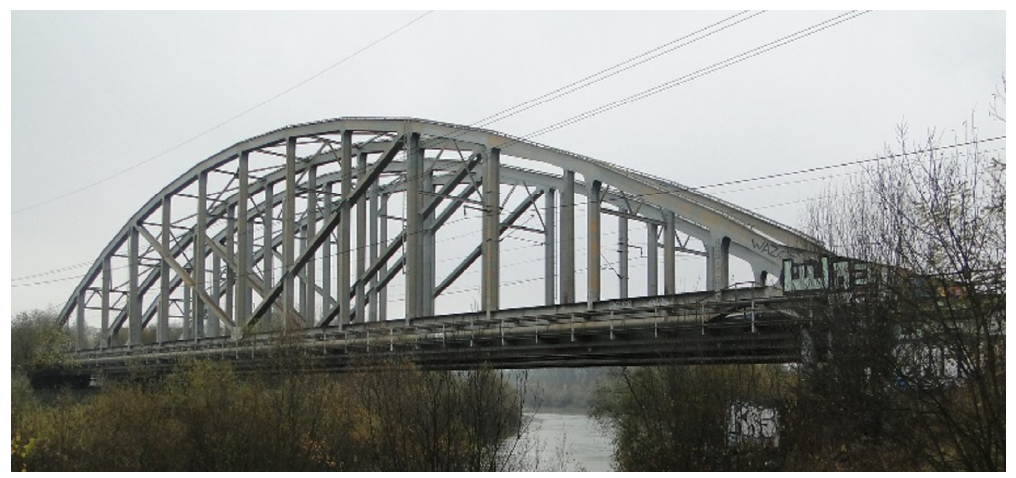
Figure 1. Photo of the selected bow-string arch bridge.